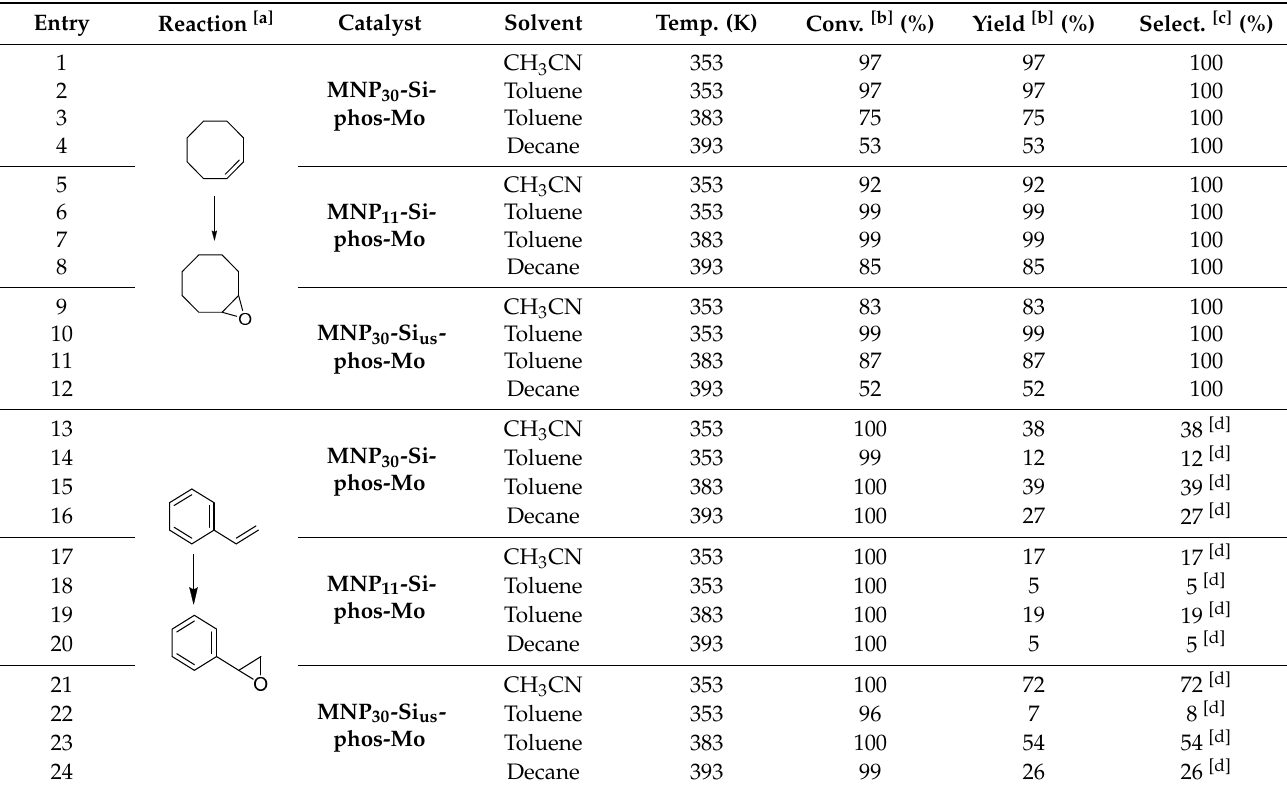
Table 1. Catalytic epoxidation of cis -cyclooctene and styrene using MNP 30 -Si-phos-Mo , MNP 11 -Si-phos-Mo, and MNP30- Si us -phos-Mo as catalysts.